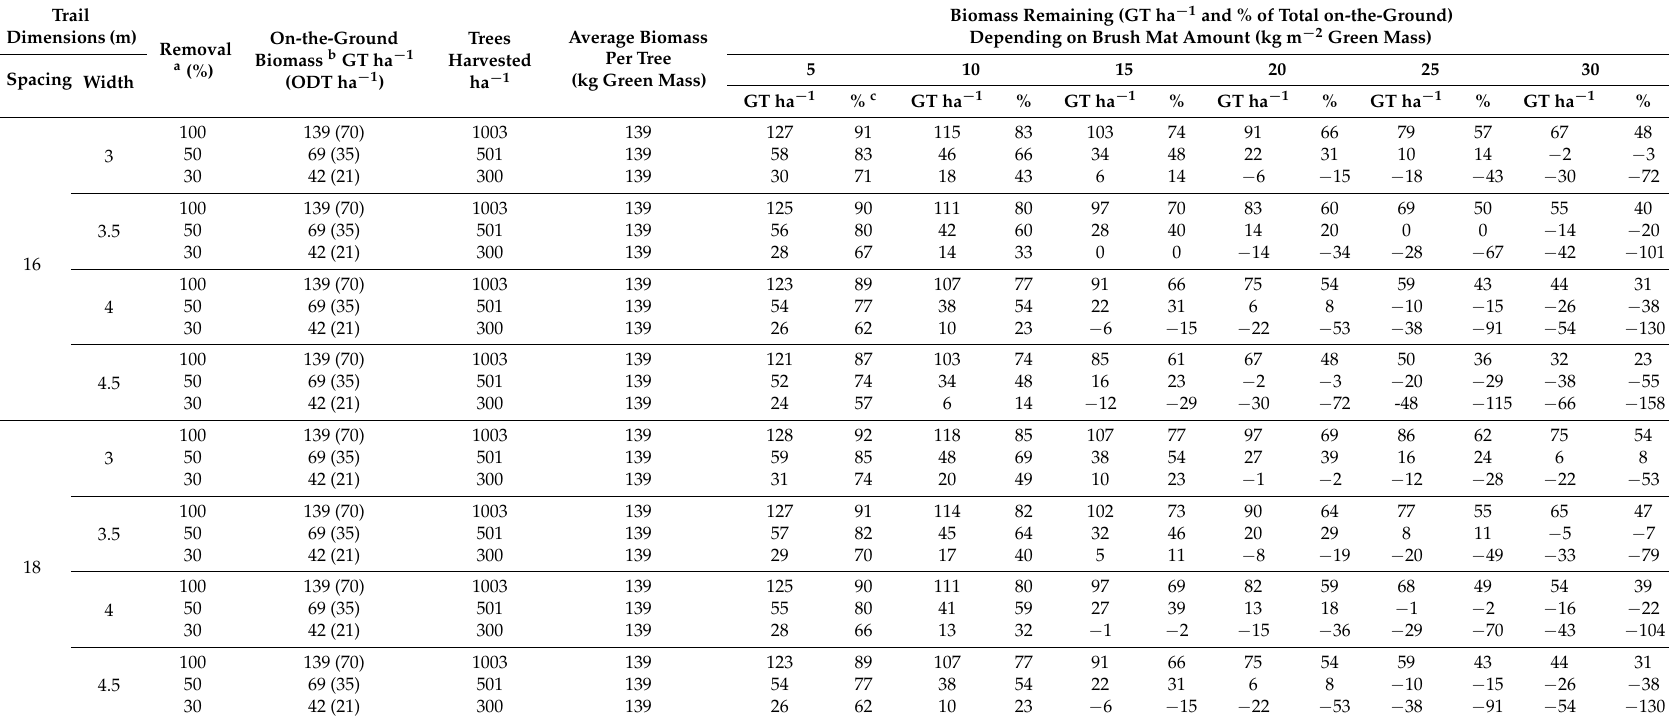
Table A7. Effect of varying brush mat requirements on remaining biomass (stand